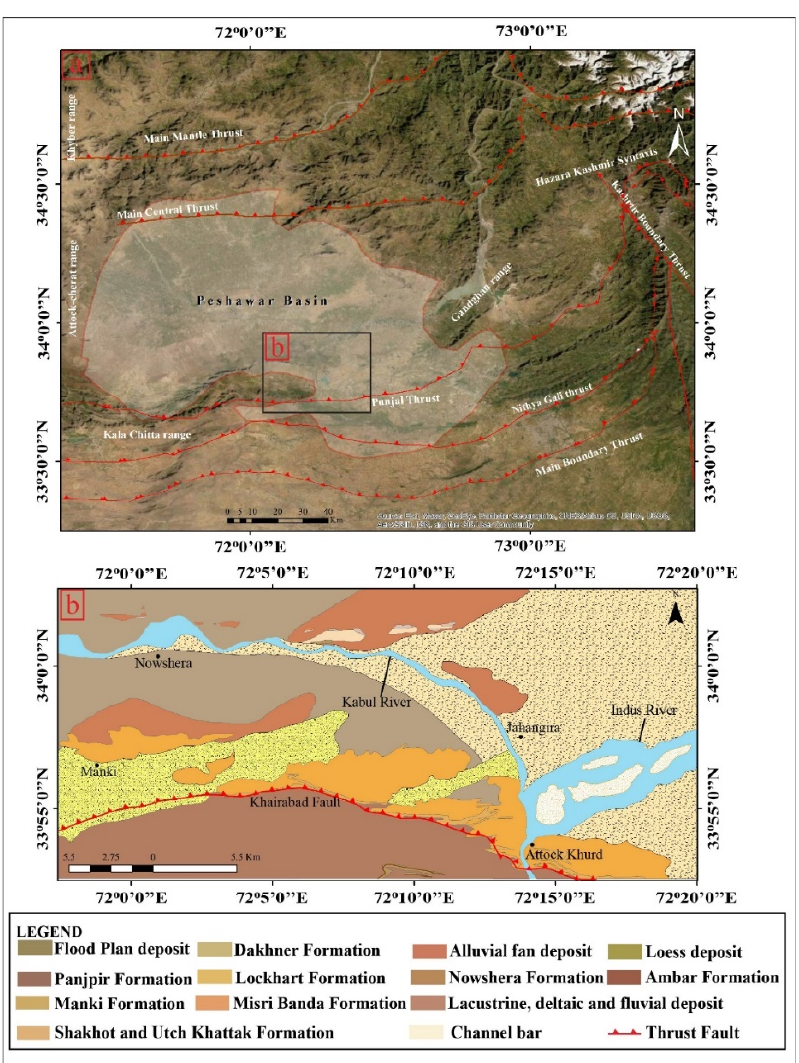
Figure 2. ( a ) The tectonic features and ( b ) the lithostratigraphic units of the Peshawar Basin modified after [5,35] .